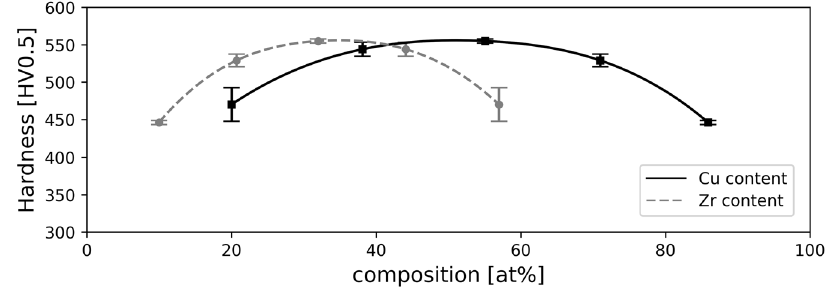
Figure 5. Approximated hardness at saturation for all investigated compositions. The highest hardness can be found for the sample with 40 wt% Cu (32at% Zr and 55.1at%